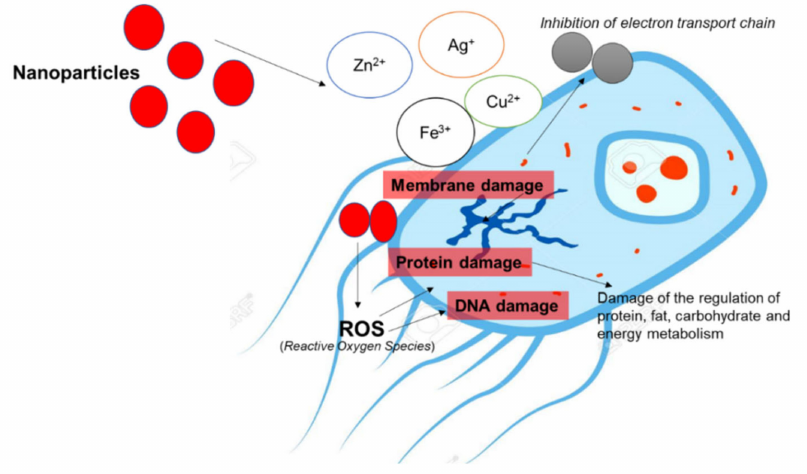
Figure 4. Simplified mechanism of nanoparticle action in the bacterial